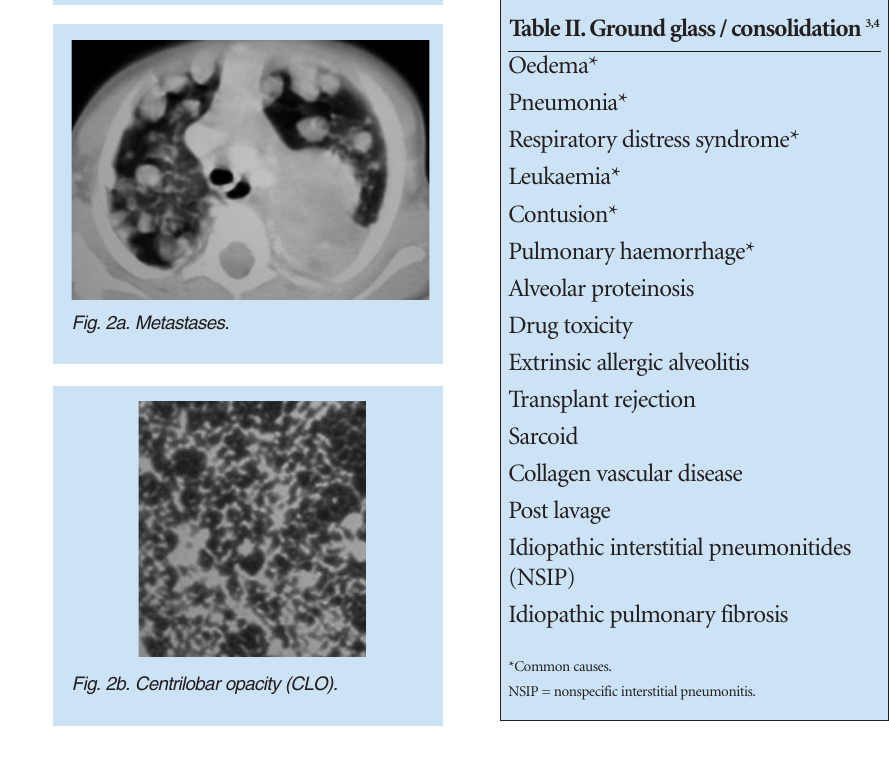
Fig.1b. Miliary TB.